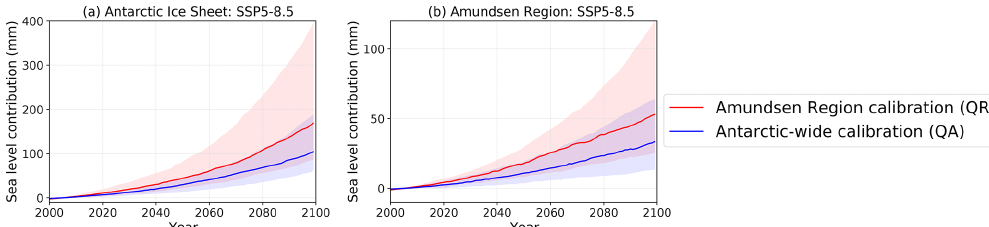
Figure 7. Projections showing the calibrated sea level contribution over the period 2000–2100 based on SSP5-8.5, for the total AIS (a) and the Amundsen Region (b) . The red lines indicate the median contribution based on the Amundsen Region calibration and the blue lines indicate the median contribution for the Antarctic-wide calibration. Results are shown for the quadratic parameterisation and thermal forcing near the ice shelf base. The shaded areas indicate the associated likely ranges (17th–83rd percentiles).